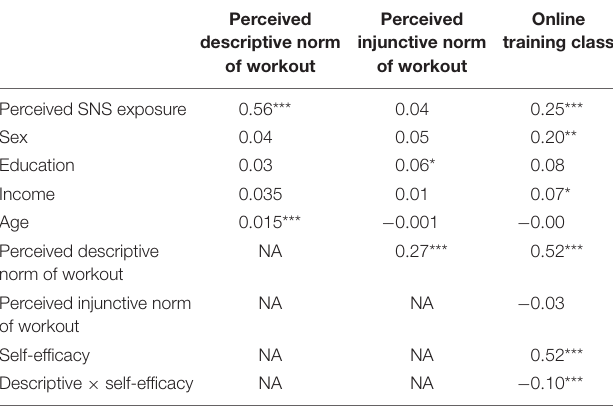
TABLE 4 | The two-step mediation model between perceived social network site (SNS) exposure and the intention to purchase online training class via perceived descriptive norm and perceived injunctive norm moderated by